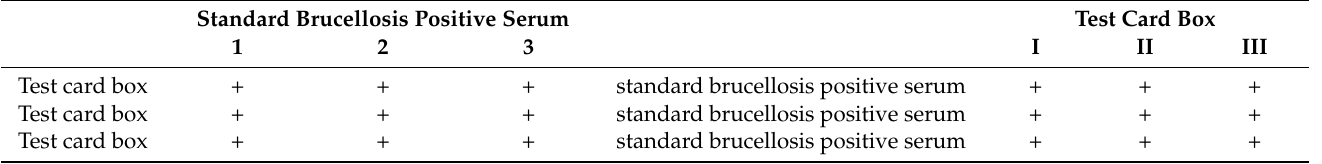
Table 1. Test Results of Stability and Repeatability of Percolation Card.